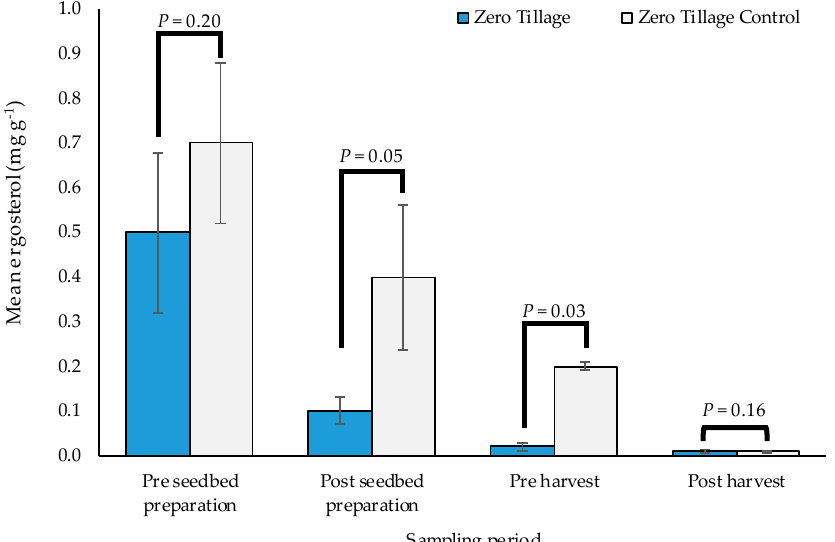
Figure 6. Mean ( n = 200) ergosterol (mg g − 1 ) extracted from zero tillage and zero tillage control soils over one cropping year (September 2018–August 2019). Multi-way ANOVA: significant difference ( F = 19.68,7 y = 24; P = 9.46 × 10 − 8 ). Post-hoc t -test: significant difference between the ZT and ZTC treatments post seedbed preparation ( F = 1.83, 1 y = 24; P = 0.05) and pre-harvest ( F = 1.71, 1, y = 24; P = 0.03). Error bars = one SEM. Table 1. Mean ( n = 300) change in ergosterol concentration ( µ g mL − 1 ) measured in CT and ZT soils at day 3, 6, 9, and 12 compared to the original ergosterol concentration ( µ g mL − 1 ) measured at day 0 before glyphosate application. for 10 di ff erent glyphosate application rates. A positive value indicates an increase in ergosterol concentration compared to day 0. Ergosterol concentration was significantly reduced in both tillage treatments with increased glyphosate application